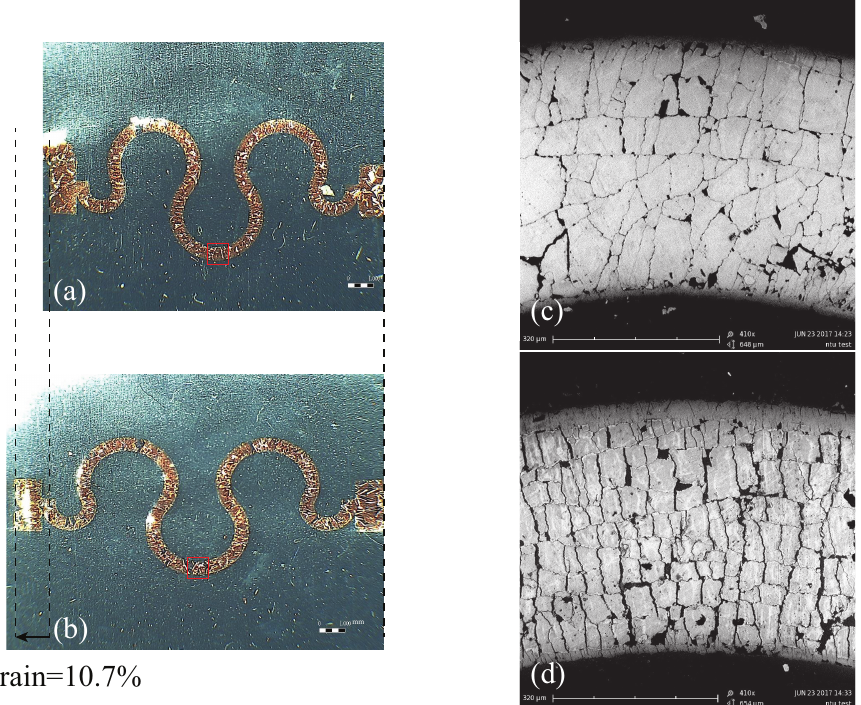
Figure 1. Photographs of unit cell of stretchable horseshoe-shape frequency-selective surfaces obtained using optical microscope with 12 × magnification: ( a ) without stretching and ( b ) with stretching [34]; ( c , d ) scanning-electron-microscope (SEM) images of meandered parts at 410 × magnification (while stretching, patterns broke apart along cracks, which resulted in loss of